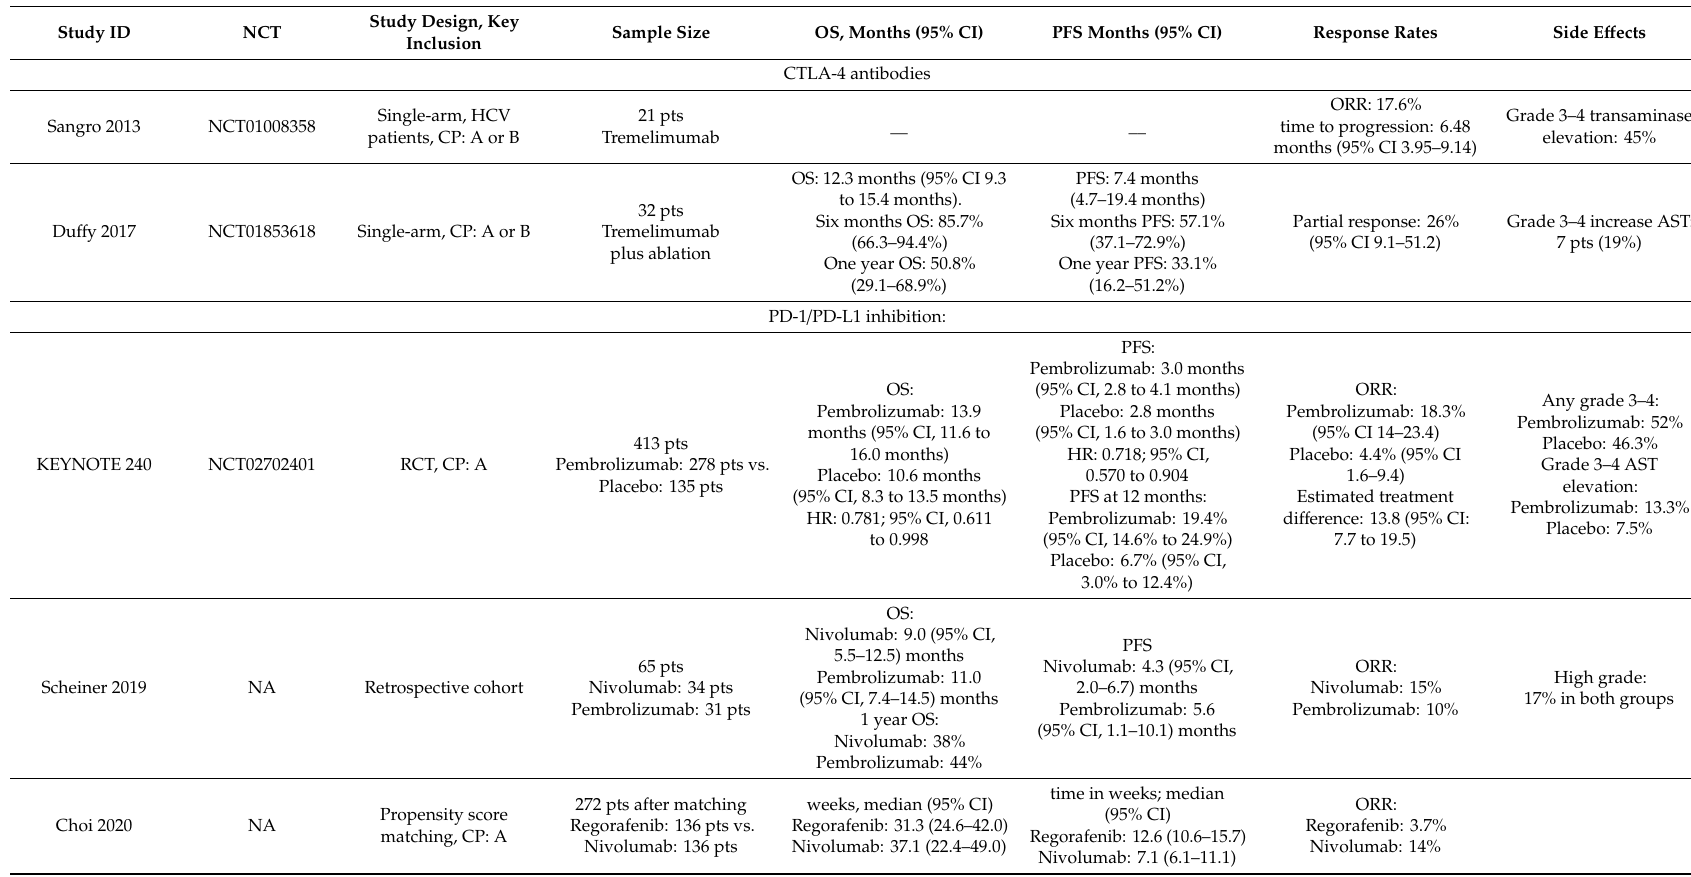
Table 2. Immune checkpoint inhibitors after failure or intolerability for first-line therapy for patients with unresectable HCC. Study